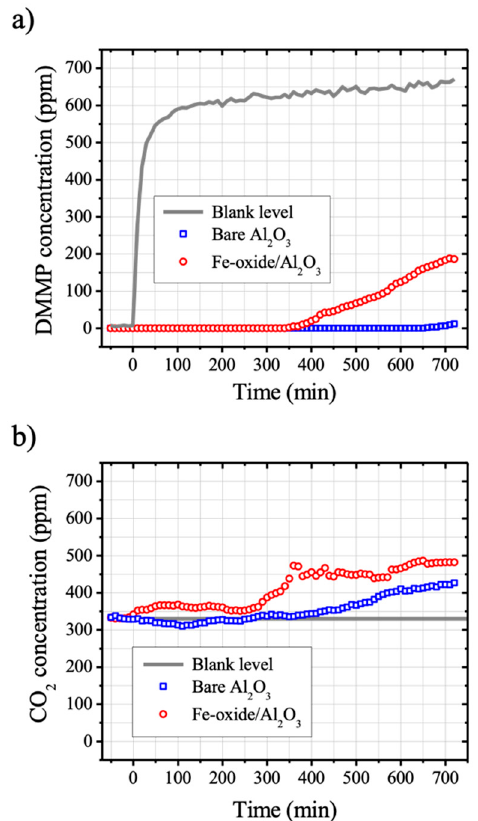
Figure 3. Concentration changes of ( a ) dimethyl methylphosphonate (DMMP) and ( b ) CO 2 in the gas passed through the empty SUS reactor (solid gray lines), the reactor filled with bare Al 2 O 3 (empty blue squares) and Fe-oxide/Al 2 O 3 (empty red circles) are displayed as a function of DMMP exposing time. Table 2. DMMP breakthrough time and CO 2 induction time of bare Al 2 O 3 and Fe-oxide/Al 2 O 3 are summarized.